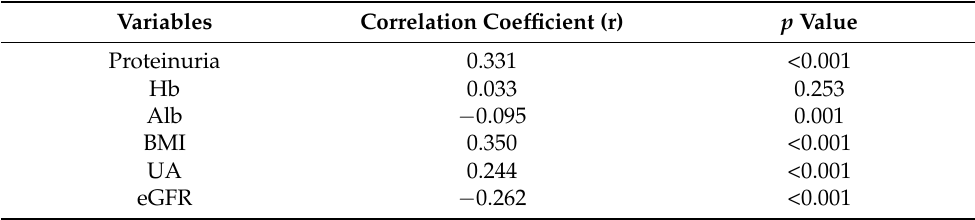
Table 2. Correlation between TyG index and potential risk factors in the matched cohort.